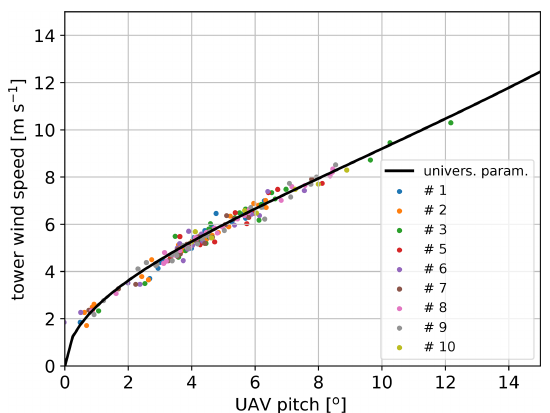
Figure 3. Ten-minute averaged wind speed for n = 34 flights drone vs. tower using the individual parameter calibration from the same 34 flights. Table 2. Accuracy of wind speed measurement in meters per second (ms − 1 ) for a dataset of 34 flights (used for calibration and valida- tion) (a) for calibration with all three parameters and (b) using only pitch offset for calibration with universal parameter values for c p and c d , 0 A 0 .